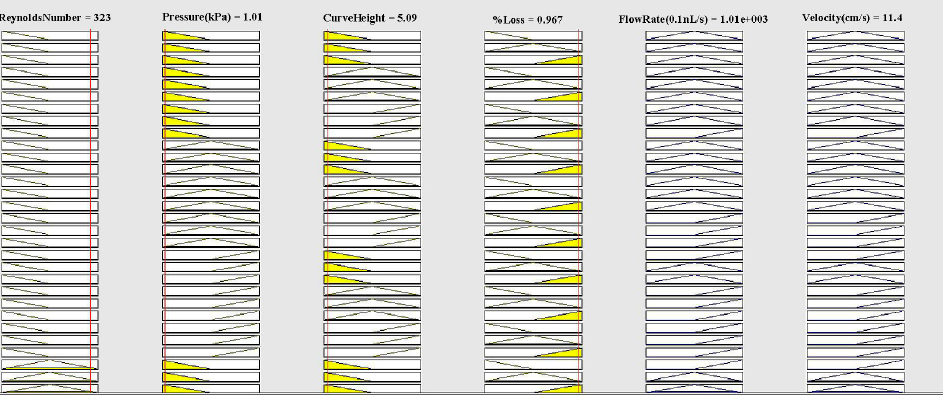
Figure 3. Rule Viewer (MATLAB).